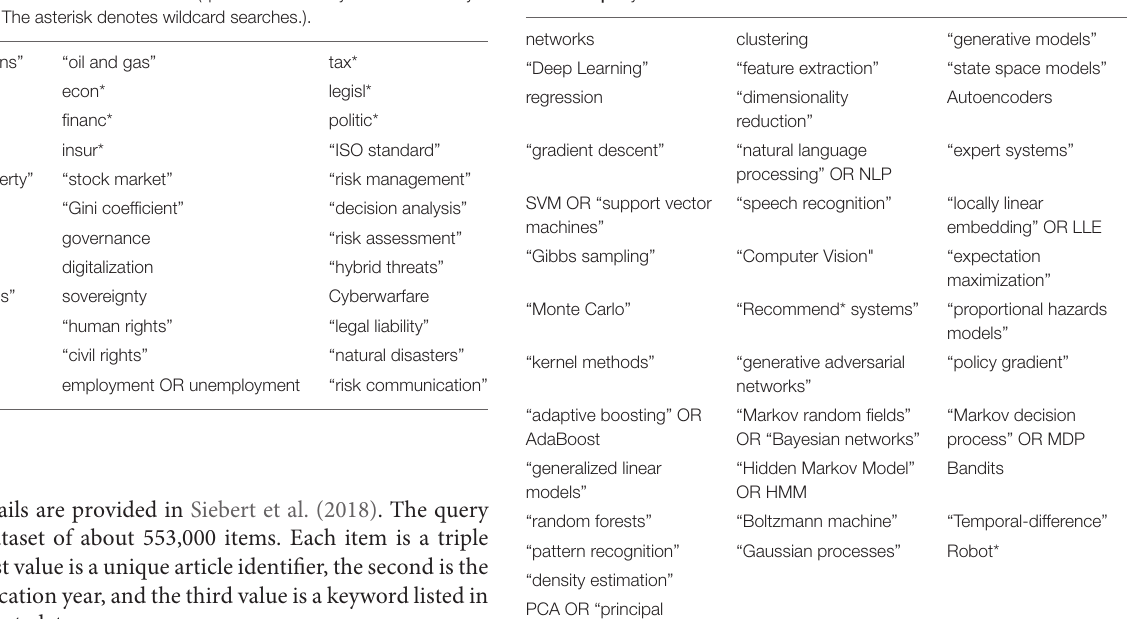
TABLE 2 | Keywords in the Technical